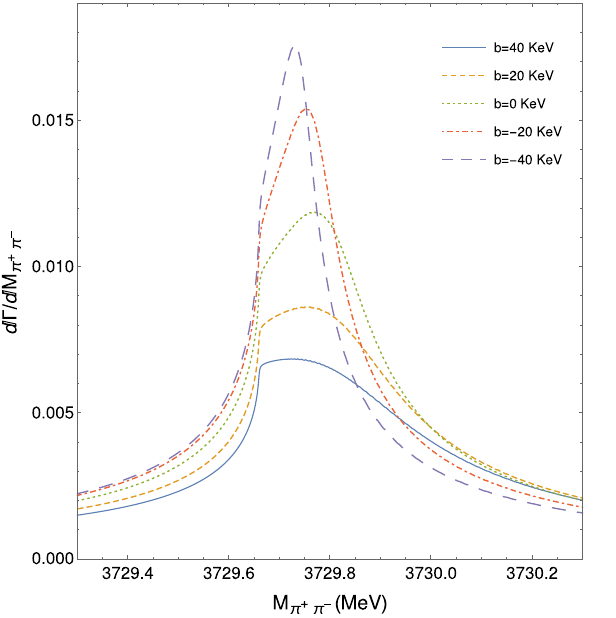
Fig. 7 d (cid:9)/ dM π + π − for different values of b = m D 0 + m D ∗ 0 − m X , where the threshold m